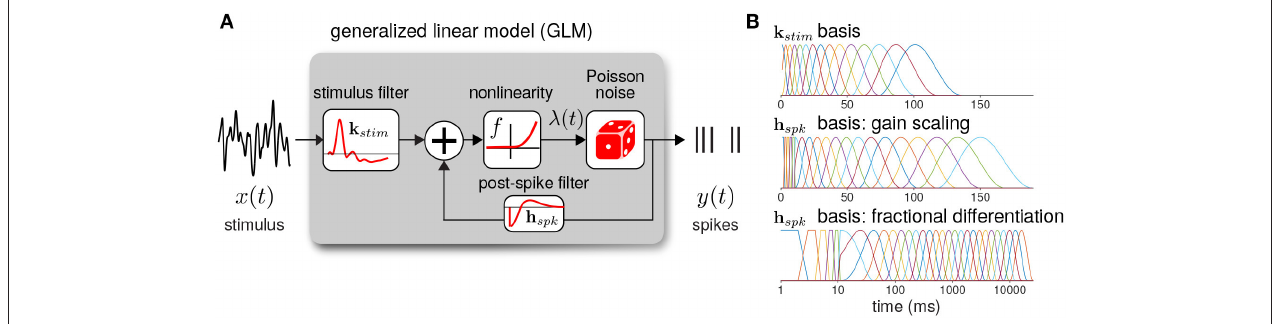
FIGURE 3 | (A) Diagram of the neural GLM that describes spiking as an autoregressive Poisson process. (B) The basis functions used to parameterize the GLM filters. (top) The stimulus basis used for all GLMs. (middle) The spike history basis used for the gain scaling simulations. (bottom) The spike history basis used for the fractional differentiation simulations. Due to the length of the spike history filters needed to capture fractional differentiation, the time axis is shown in log scale.